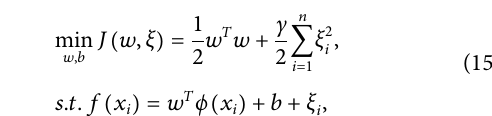
Frontiers in Energy Research |